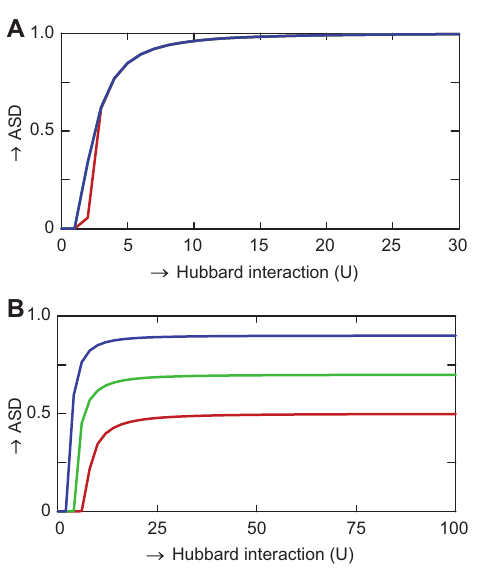
Figure 6 ASD as a function of Hubbard interaction strength U for single-channel mesoscopic rings. (A) Half-fi lled case. The red, green, and blue curves correspond to N = 10, 30, and 50, respectively. (B) Non-half-fi lled case with N = 20. The red, green and blue curves = 10, 14, and 18, respectively. correspond to N e